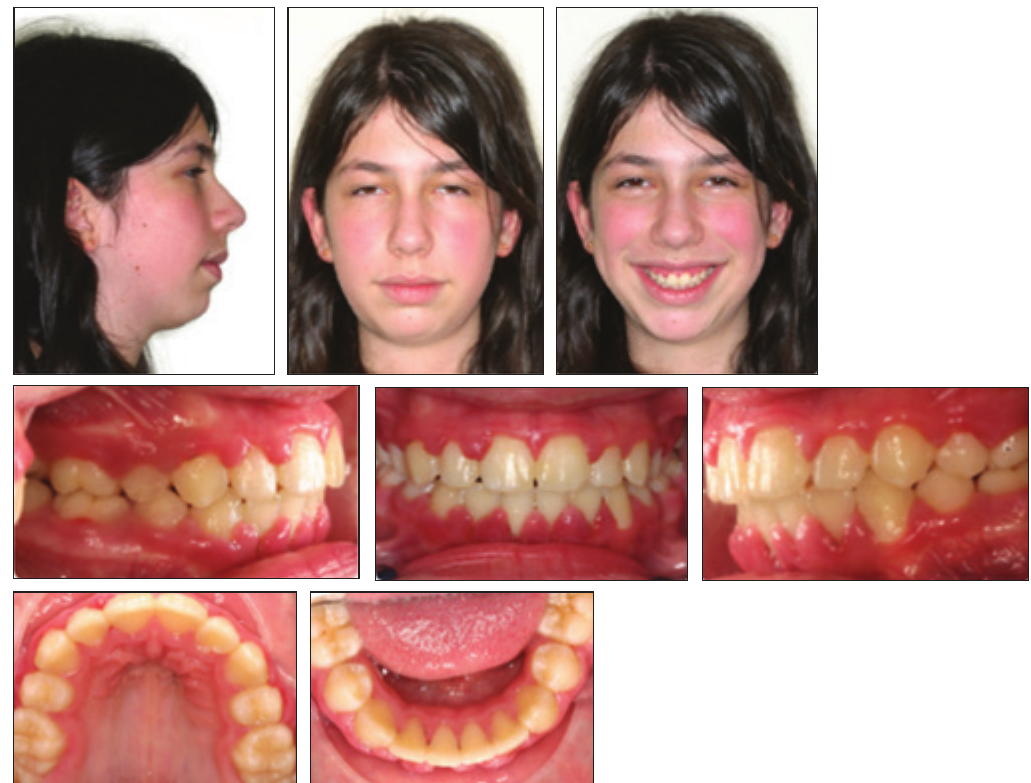
Figure 1. Intra-oral and extra-oral photographs following initial orthodontic treatment; December 2009.